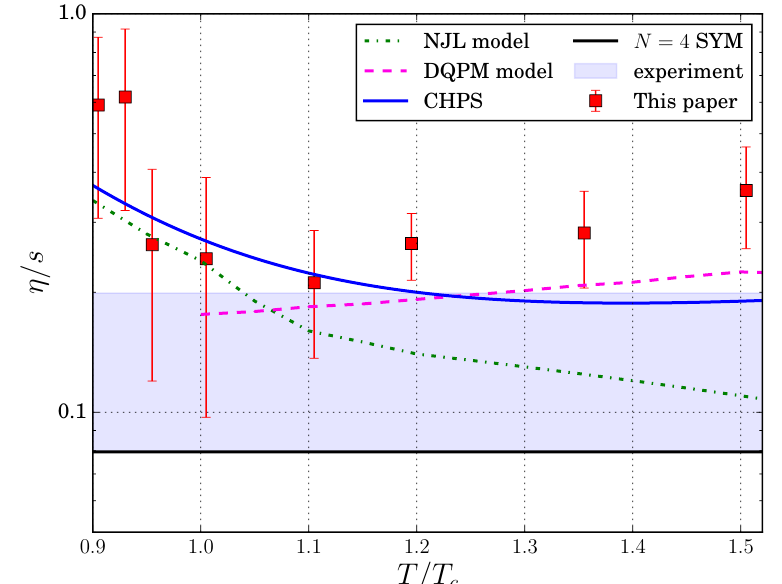
Figure 6 . The ratio (cid:17)=s in QCD for various temperatures. The red square points represent the estimation of the (cid:17)=s in QCD done in this paper. The green curve is the result of the NJL model [10], the violet curve is the result of dynamical quasiparticle approach [11], blue curve is the result of [12] and black line is the result of the N = 4 SYM. In addition we plot the grey region which shows the experimental bound on the ratio (cid:17)=s found from the experiment data